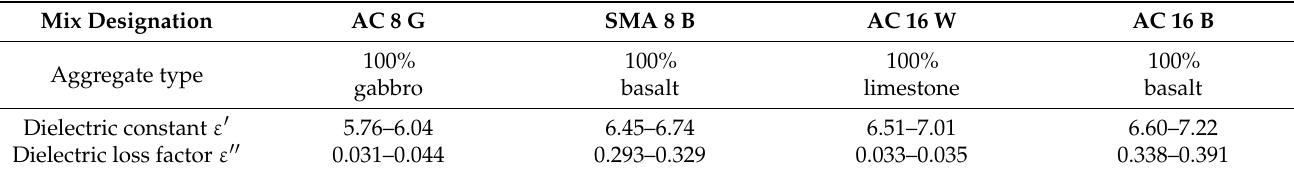
Table A4. Asphalt mix dielectric measurements at 23 ◦ C, (sequential measurements at f = 1.3, 1.9, 2.2, 2.84, 3.97 and 5.23 GHz), 95% Confidence Interval for the mean.